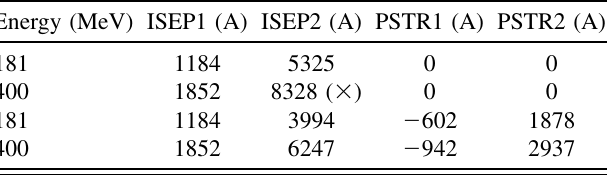
TABLE I. A summary of required currents of the ISEPs and PSTRs power supplies for center injection in the present 181 MeV and upgraded 400 MeV injected energies. The mea- sured 181 MeV injection parameters are scaled for an increase of the magnetic rigidity ( B (cid:2) ) in order to obtain those required for the 400 MeV. The capacity of ISEP2 for the center injection at 400 MeV exceeds the limit and thus PSTRs are needed in addition to ISEPs. The reference center injection orbit obtained by using PSTRs and ISEPs at the present 181 MeV has already been confirmed that such a center injection orbit can thus be achieved at the 400 MeV as currents for all power supplies are calculated to be within the